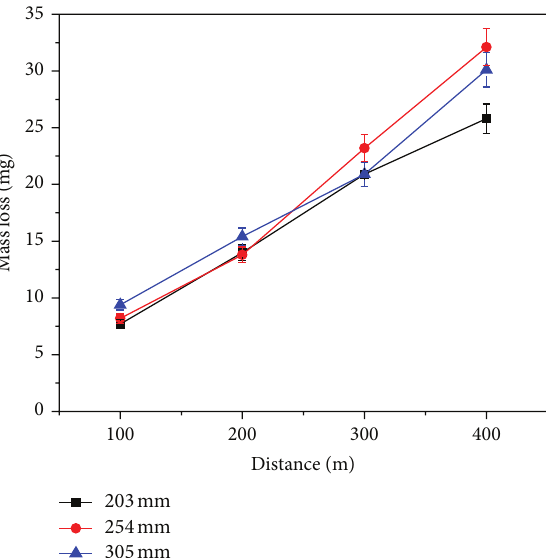
Figure 10: Coefficient of friction results in a distance of 100 m. Figure 11: Mass loss for spraying distances of 203, 254, and 305 mm Co 32 Ni 21 Cr 8 Al 0.5 Y